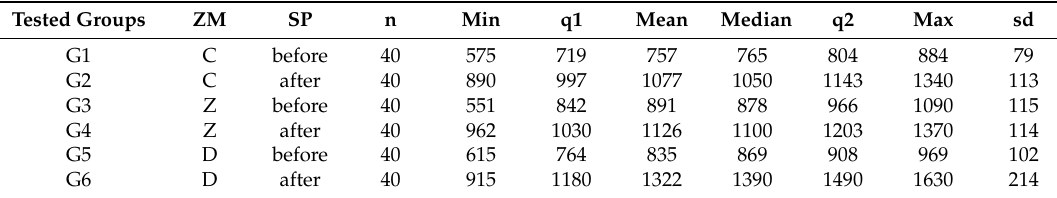
Table 2. Data summary for Normal assumption. n: number of observations; q1: first quartile; q2: third